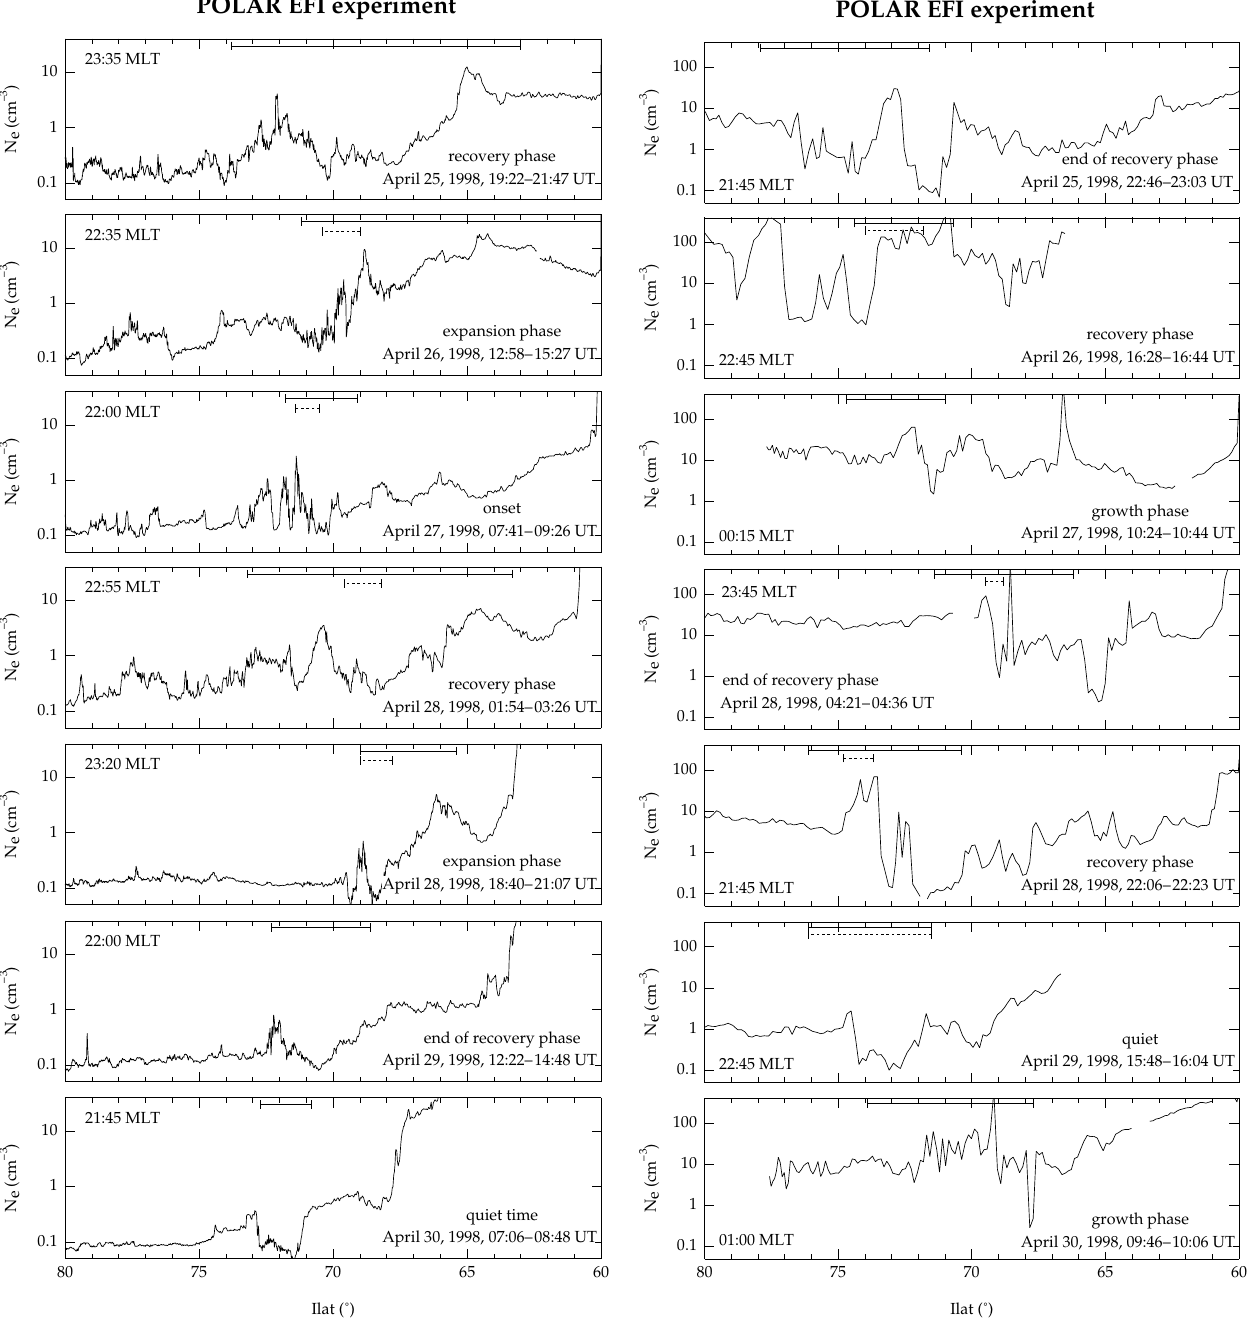
Fig. 8. (a) Crossings of the northern auroral zone in the pre-midnight sector on seven consecutive orbits of 25–30 April 1998. The crossings (the UT interval is given in each panel) happened during different geomagnetic conditions, as marked in each panel. The solid horizontal bars indicate the locations of the electric field perturbations; the dashed bars show the locations of very strong electric fields, when they existed. (b) same as (a) but for the southern auroral zone.